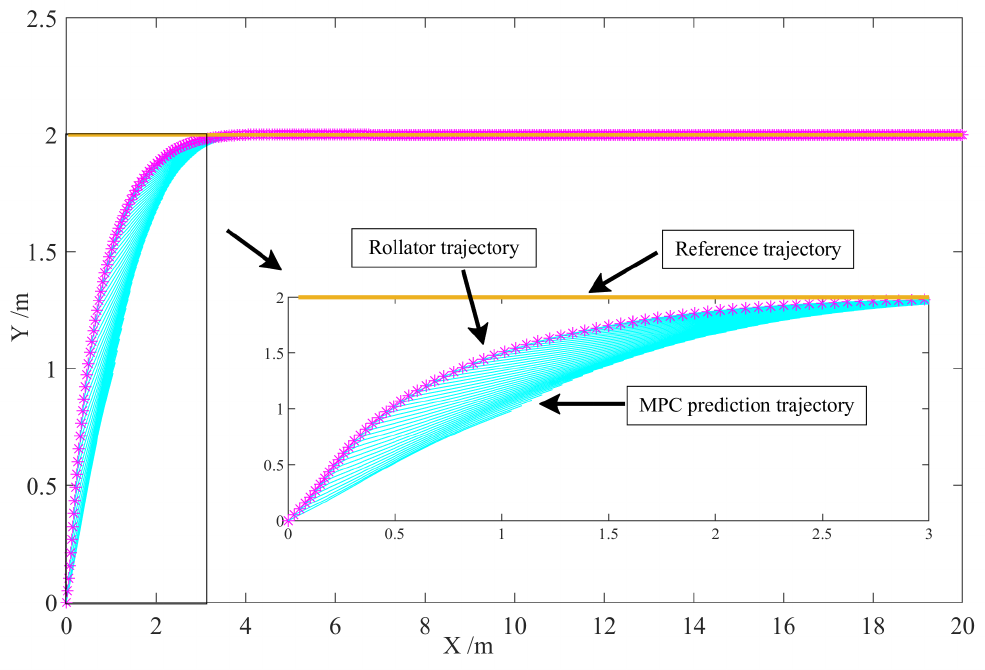
Figure 9. Results of MPC-based Predicted